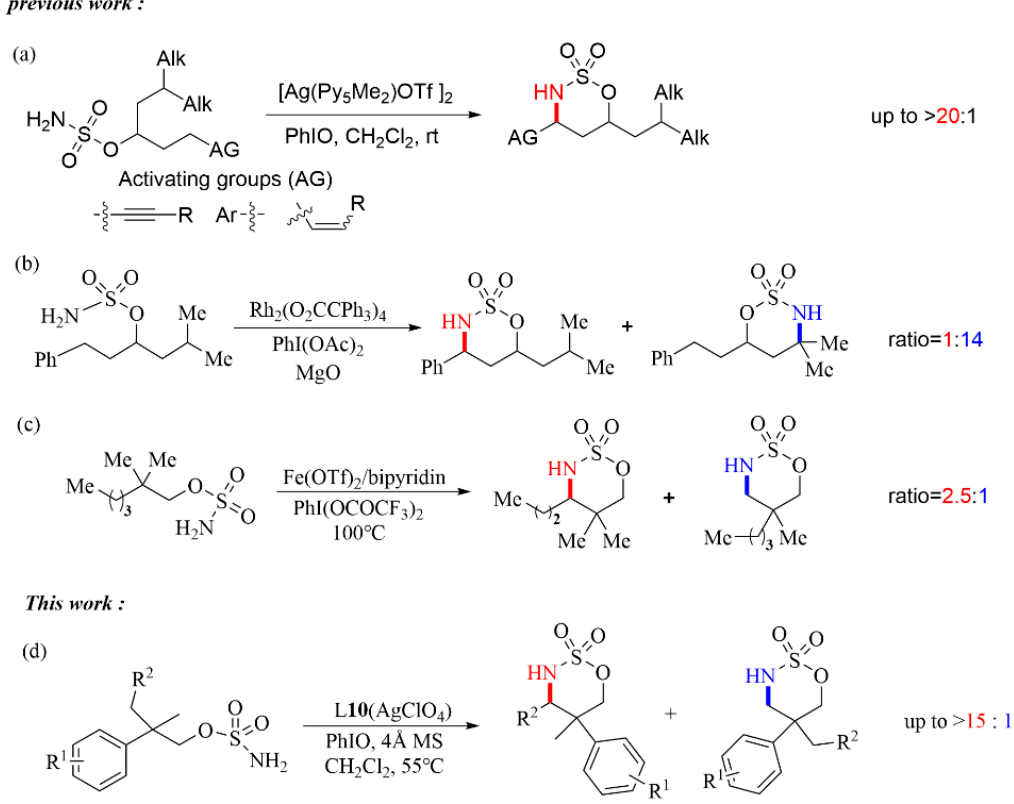
Scheme 1. Representative examples of selective amination